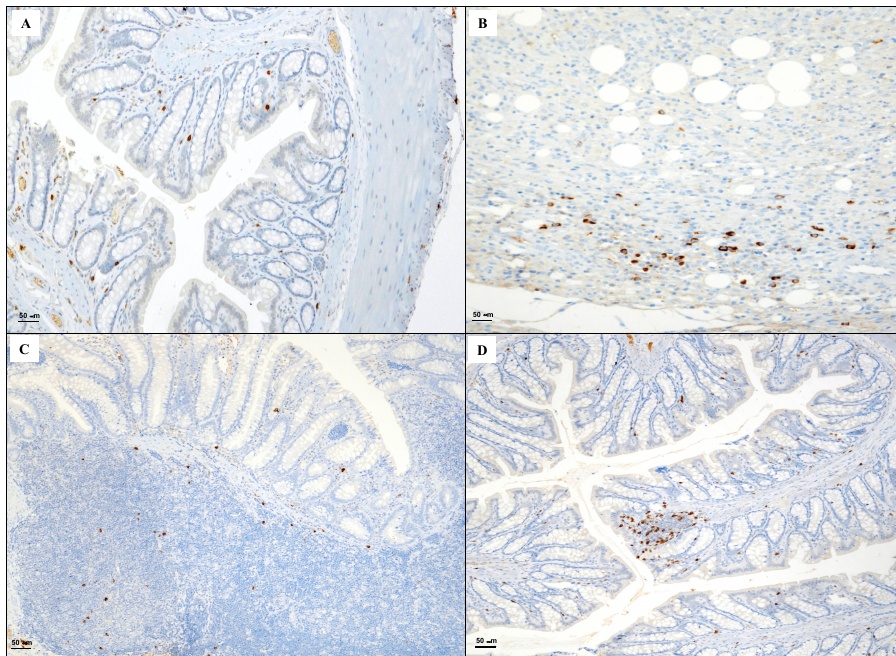
8 of 16 Figure 4. Representative CD3 immunostaining (original magnification ×20) of tissues derived from control ( A ), DNBS + Drug vehicle ( B ), DNBS + Poly ( C ), and DNBS + Poly + HA ( D ). Section obtained from the control group showed sporadic CD20 positive B lymphocytes (Figure